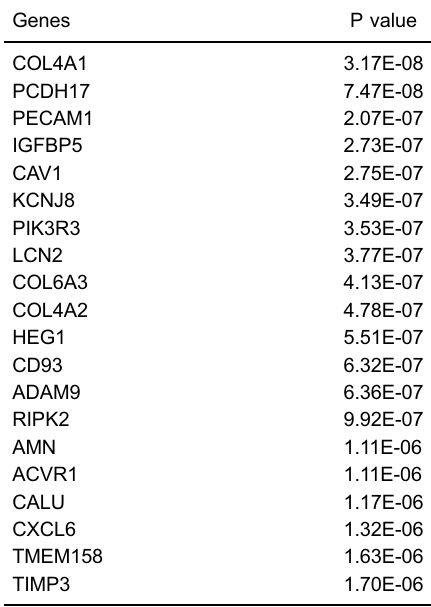
Table 1. List of the top 20 differentially expressed genes